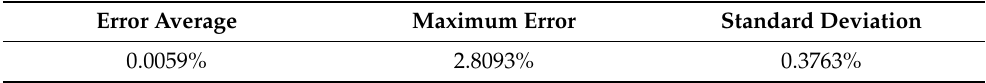
Table 8. Ratio between statistical measures: testing B.